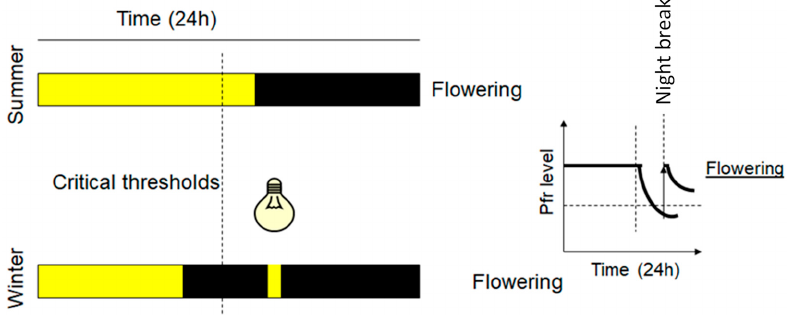
Figure 4. LD plants and fl owering control. Yellow color represents daylight or lighting and black color the night or dark induced by covering the plants LED light with emission at 730 nm converts the Pfr into Pr and induces the fl owering of LD plants, overcoming the critical time threshold. On a biochemical level, right graph, short ( fl ash) lighting induces night break and increases the Pfr level, and the induction of LD plant fl owering occurs when the Pfr level exceeds a critical concentration threshold.